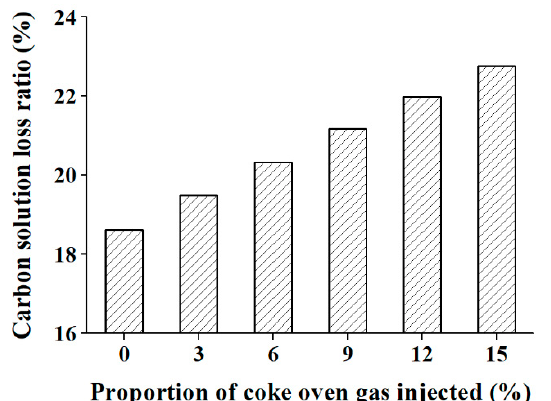
Figure 7. Carbon solution loss ratio at di ff erent amount of coke oven gas injected.